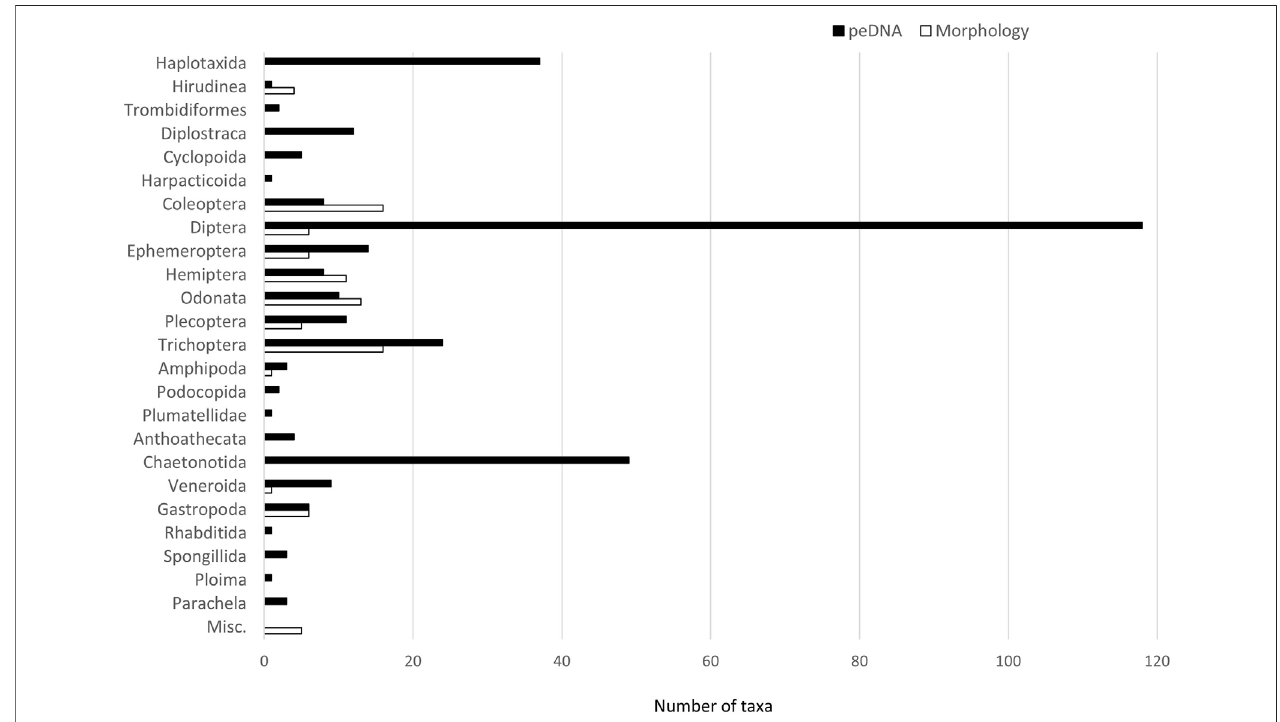
FIGURE 2 | Number of taxa by orders (and class Gastropoda) identi fi ed by metabarcoding of peDNA and morphology. Misc. = taxa determined only by morphology above the order level (Ostracoda, Oligochaeta, Nematoda, Hydrozoa and Hydrachnidia).